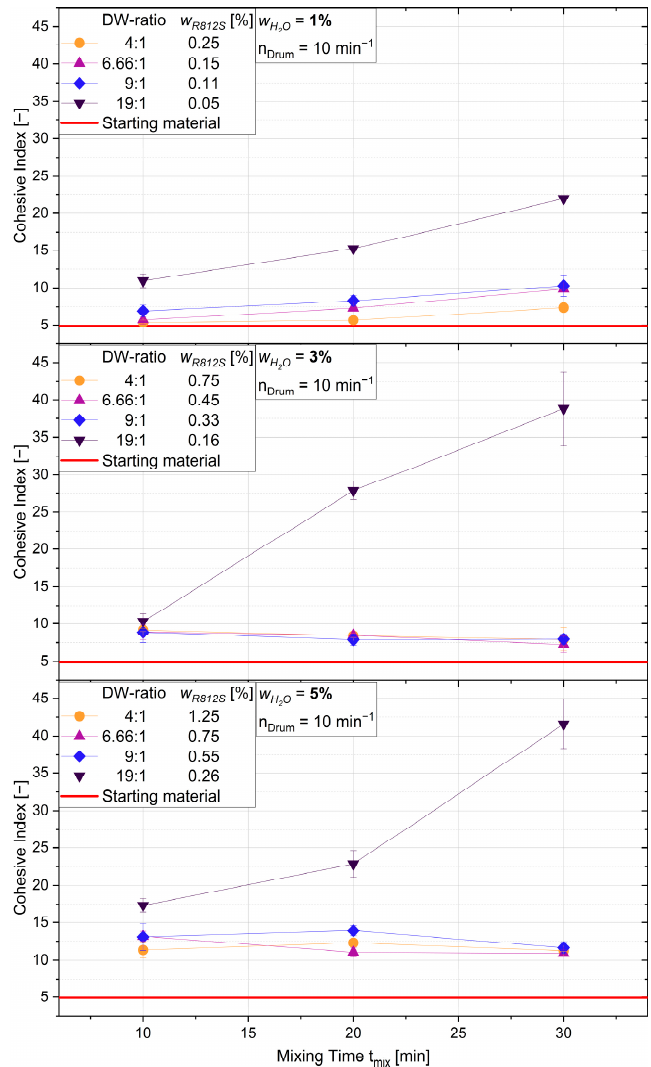
Figure 12. Cohesive index in dependence of the mixing time for mixtures containing different dry water variants and total water contents: w H2O = 1% ( top ), w H2O = 3% ( centre ), and w H2O = 5% ( bottom ). Further insight into the functionality of DW is demonstrated in Figure 13, where mi- cro-computed tomography (µCT) images of a mixture of coarse sand (grey) and water (blue) is depicted on the left as well as a mixture of coarse sand (grey) and DW (light blue) presented on the right. µCT images were taken of selected samples intending to explore events that prevail between DW and sand during mixing or rather the effect of mixing on the final product. The presented mixtures contain water contents of w H2O = 5% for both solely water (left) as well as DW 6.66:1 (right). Figure 13 demonstrates complete networks of liquid capillary bridges, which occur by adding the aforementioned water content with- out DW. For mixtures of aggregate sand and DW, DW mainly resides in the valleys of the particle surface and does not seem to create an even coating on sand particle surfaces. A clear distinction between DW and water alone was not achieved by µCT imaging. Possi- bly, layers of R812S are too thin to be detected or the difference in density between sand and hydrophobic silica is insufficient for a clear distinction of the respective materials. Figure 13. µCT-images of mixtures containing coarse sand (grey) and: (1) water (blue) with w H2O = 5% ( left ) and (2) dry water DW 6.66:1 (light blue) with w H2O = 5% ( right ).